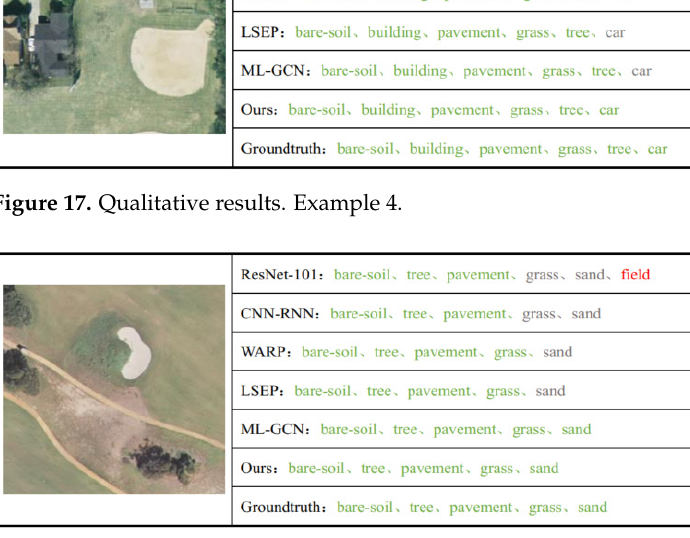
Figure 18. Qualitative results. Example